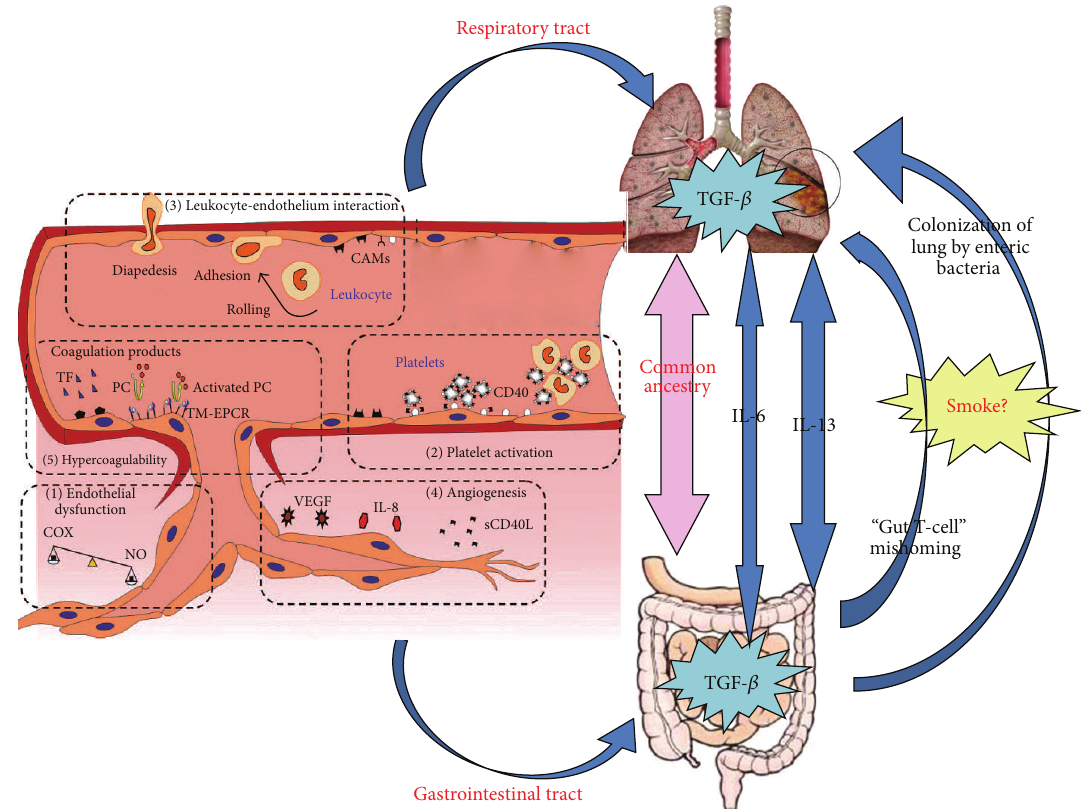
Figure 7: Possible microvasculature mechanism on how colitis affects lungs in the immune-TNBS-ethanol-induced UC rat model, perhaps related to the common ancestry of the bowel and the bronchial tree. Some etiological factors like smoke exposure may lead to gut-originating T-cell mishoming and promoting growth of enteric bacteria in the lung during inflammatory responses. Systemic IL-6, in conjunction with localized TGF- 𝛽 , may drive cross-organ Th17-polarized inflammation. Systemic IL-13 may drive aberrant NKT and macrophage responses across organs. Inflammation triggers a change in the endothelium of the intestinal and pulmonary vasculature leading to increased adhesion molecule expression, platelet activation, angiogenesis, and coagulation with decreased endothelial barrier